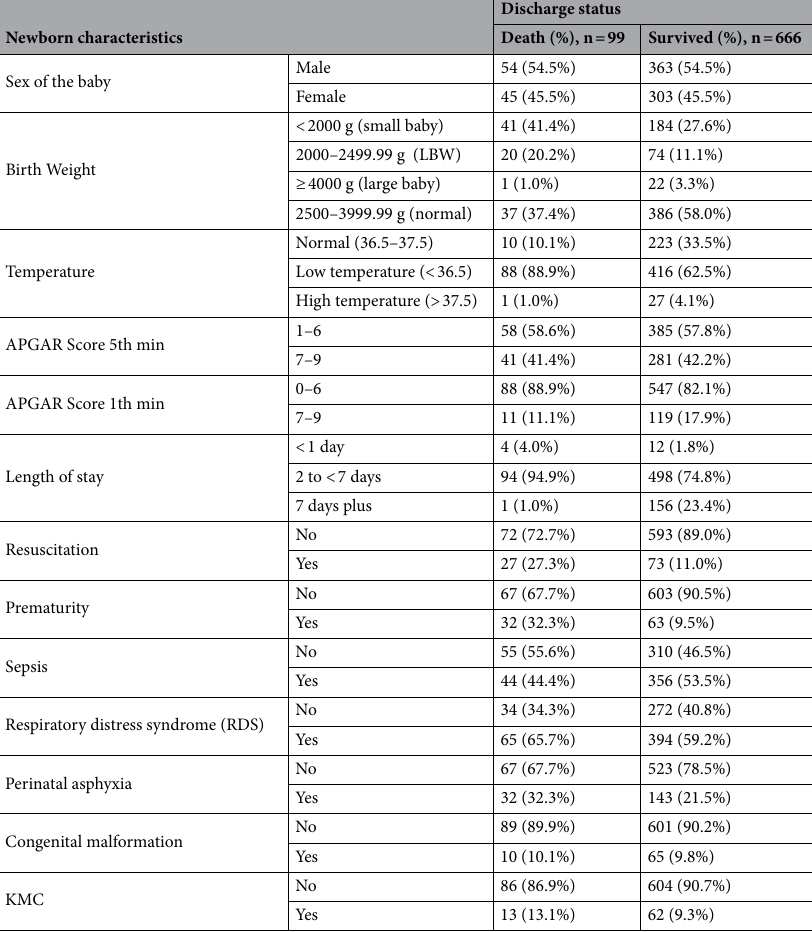
Table 1. Characteristics of NICU admitted neonates at Referral Hospital, Jigjiga from May 2019–2021.